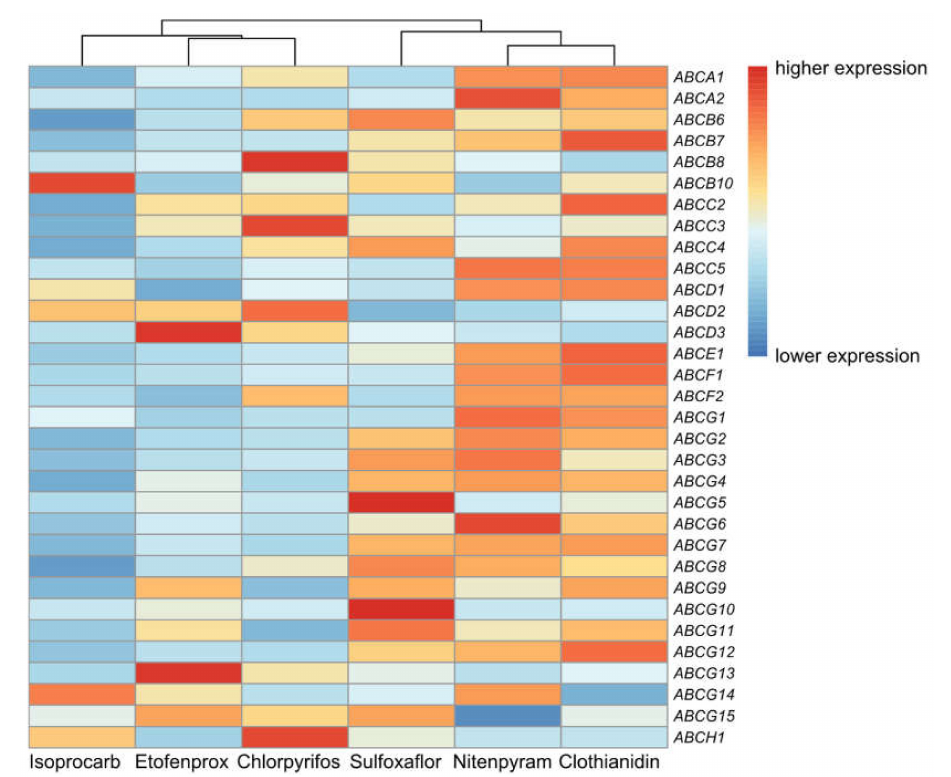
Figure 4. Relative expression levels of 32 ABC transporters in N. lugens nymphs treated with insecticides, as determined by qRT-PCR. Letters on the right are the gene names for the 32 ABC transporters. Treatments are given at the bottom. The mRNA levels were normalized by the expression of the respective gene in untreated nymphs. Blue indicates downregulated, and red indicates upregulated. The more intense the color, the more pronounced are the changes in expression